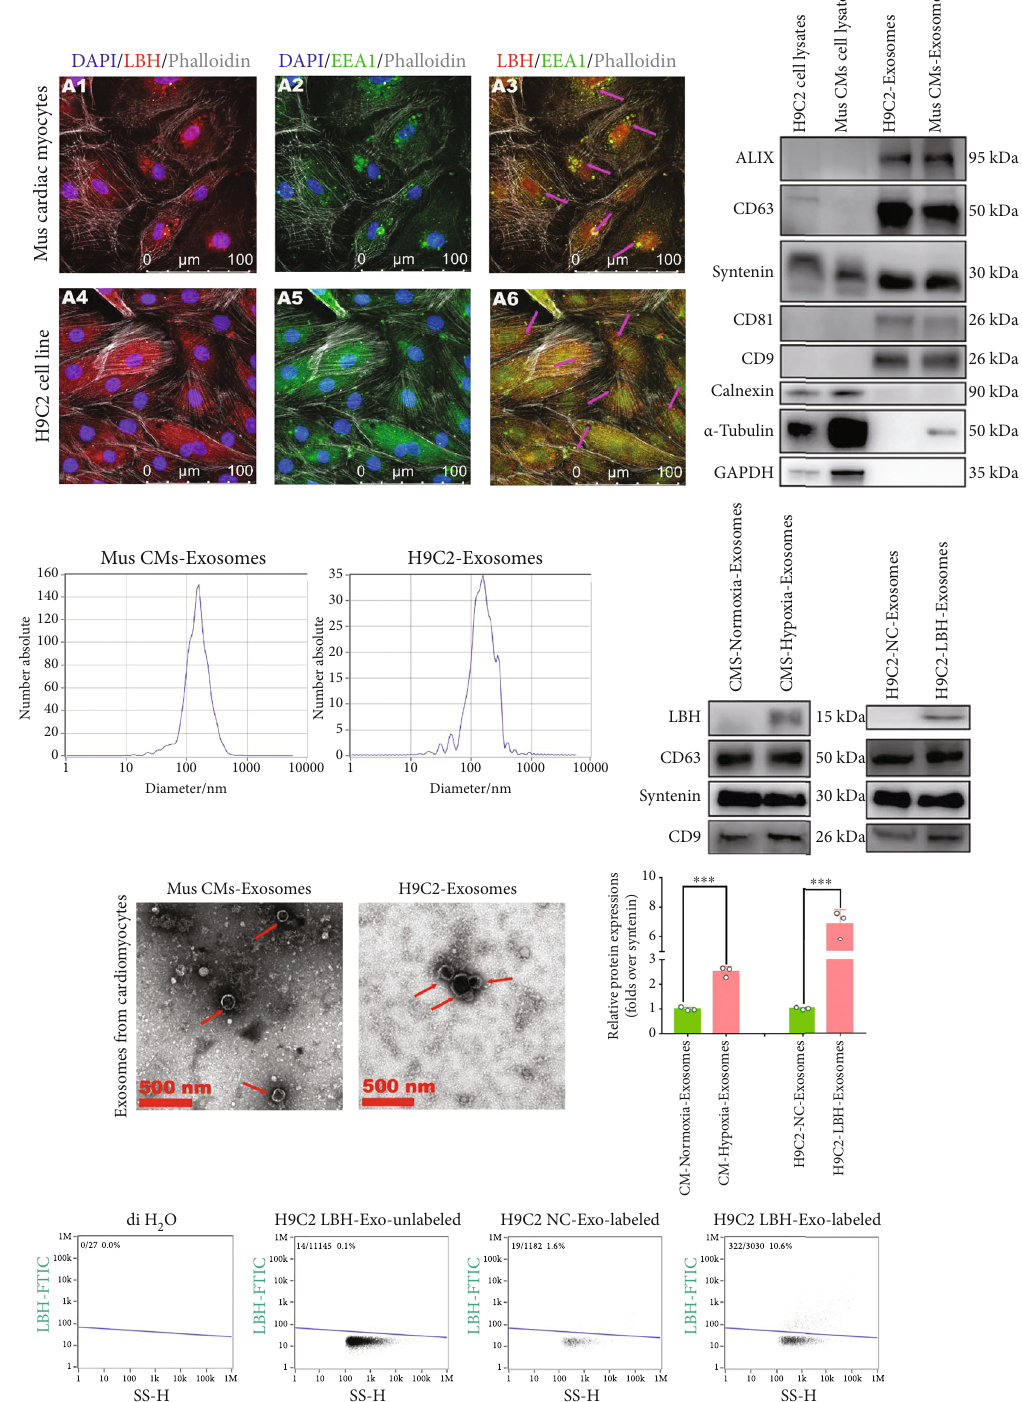
Figure 2: The exosomal distribution of LBH protein is elevated in the exosomes secreted by LBH-upregulated CMs under hypoxia. (a) Representative confocal microscopy images of dual staining with anti-LBH (red) and anti-EEA1 (green) in mouse primary CMs and H9c2 cells. Colocalization of LBH and EEA1 was observed in the perinuclear cytoplasm of both primary CMs and H9c2 cells (indicated by magenta arrows). (b) The distribution of particle size/concentration of exosome samples analyzed by NTA. (c) Representative TEM images of exosome samples derived from mouse primary CMs and H9c2 cells (exosomal structures were indicated by red arrows). (d) Protein expression of CD9, CD63, CD81, ALIX, syntenin-1, and calnexin in cell lysates and the corresponding CM-derived exosomes from both mouse primary CMs and H9c2 cells. (e) Western blotting measuring LBH protein levels in CM LBH+ exosomes and CM NC exosomes ( ∗∗∗ p < 0 : 001 vs. mouse CM-normoxia-exosomes/H9c2-NC-exosomes). (f) Exosome samples derived from mouse primary CMs under normoxia or hypoxia were tested by nano fl ow cytometry after being stained with